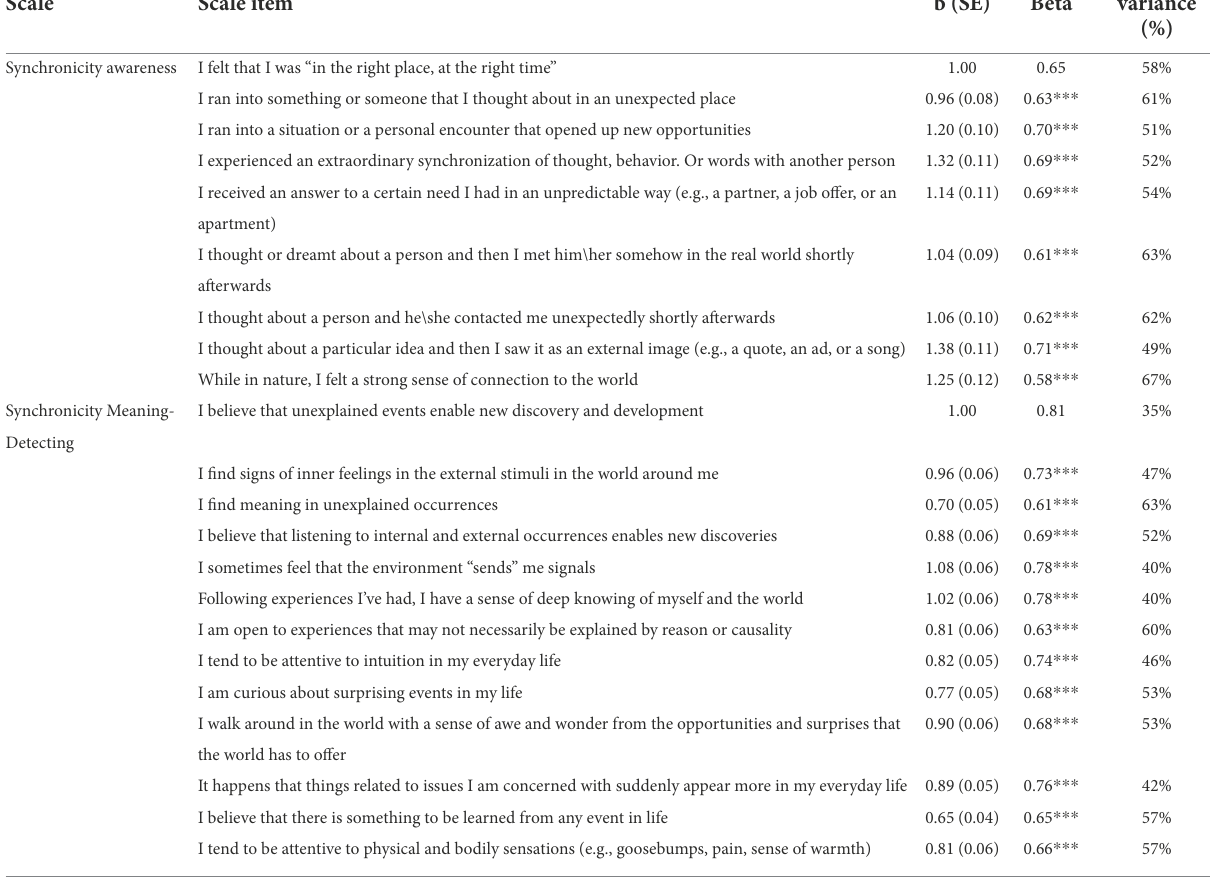
TABLE 3 Study 2-synchronicity items factor loadings (CFA).